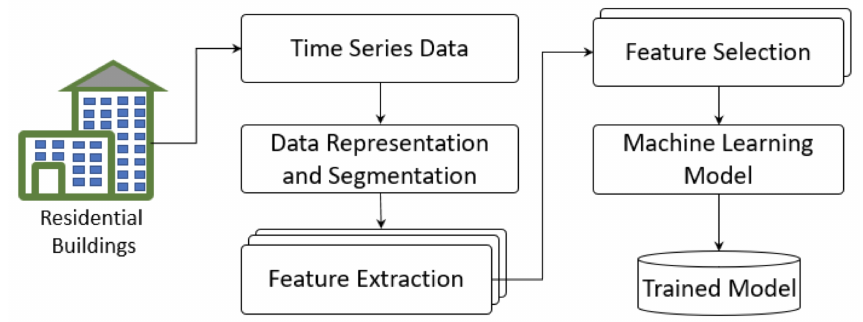
Figure 3. The model training mechanism to identify the different household characteristics.